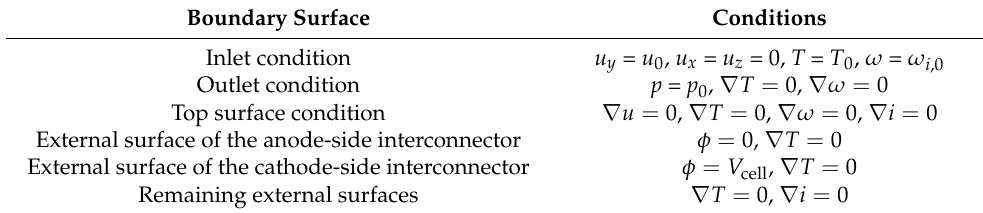
Table 2. The boundary conditions of the simulation model in the present